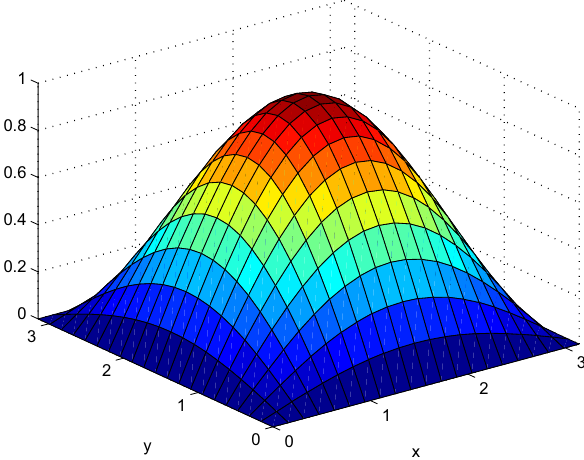
Figure 1: The exact solution at = T 1 with = α 1.5 , = M 20 , and = N 40 for Example 1.